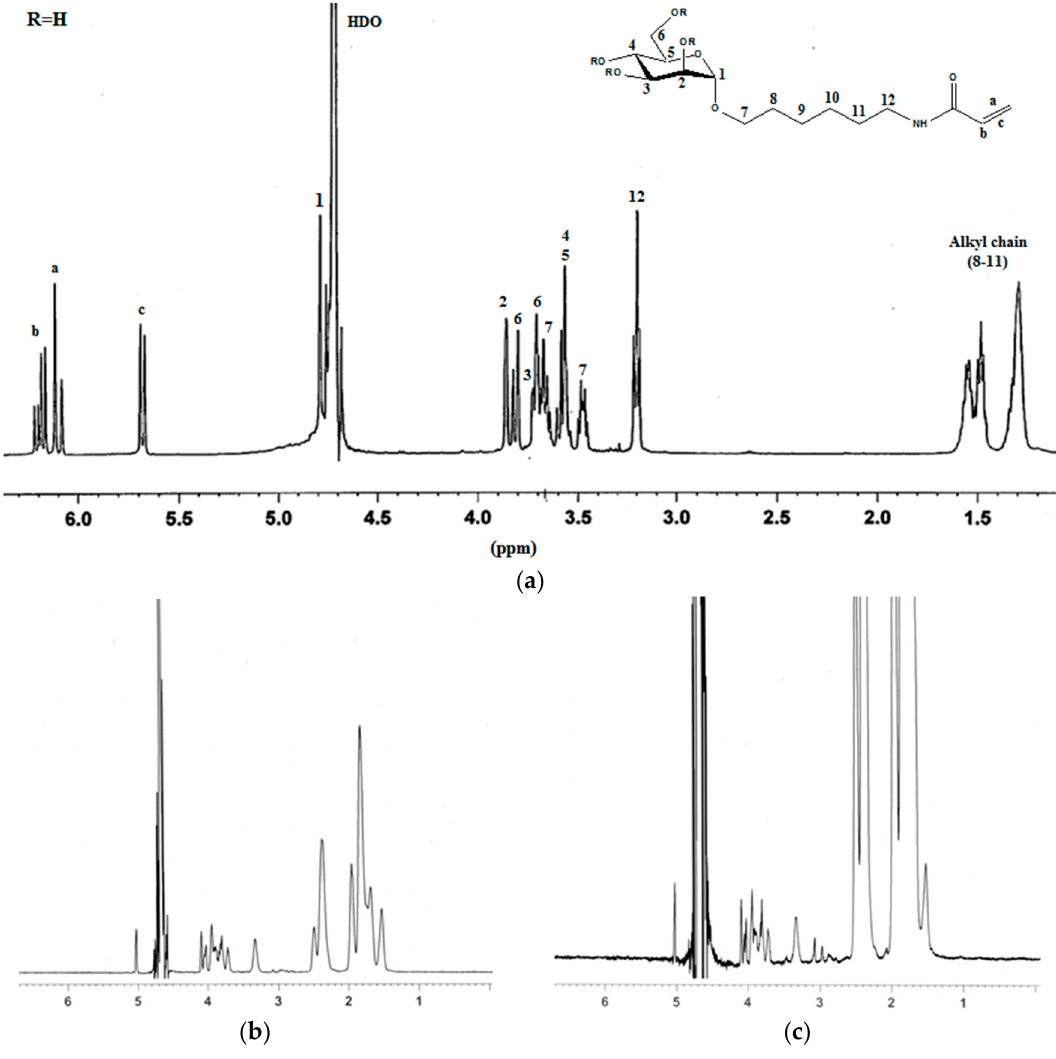
Figure 1. 1 H-NMR of (400 MHz, D 2 O): ( a ) glycomonomer 7 ; ( b ) copolymer 8a ; ( c ) copolymer 8b .